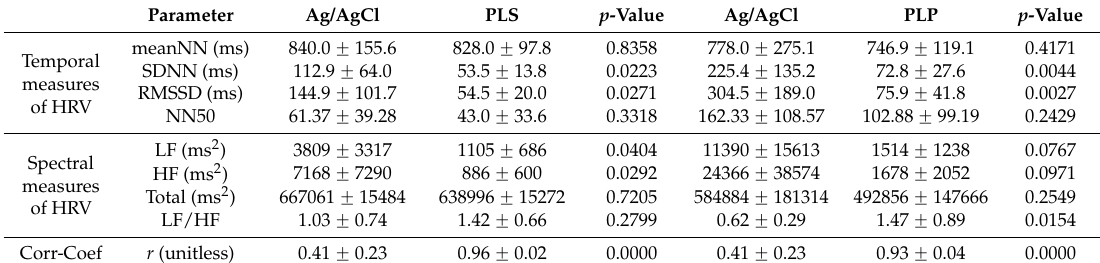
Table 3. Electrocardiogram signal quality—freshwater immersion without movement condition.